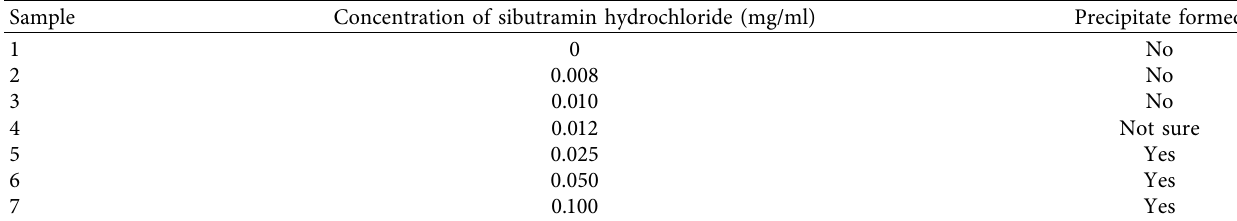
Table 8: The determination of detection limit.